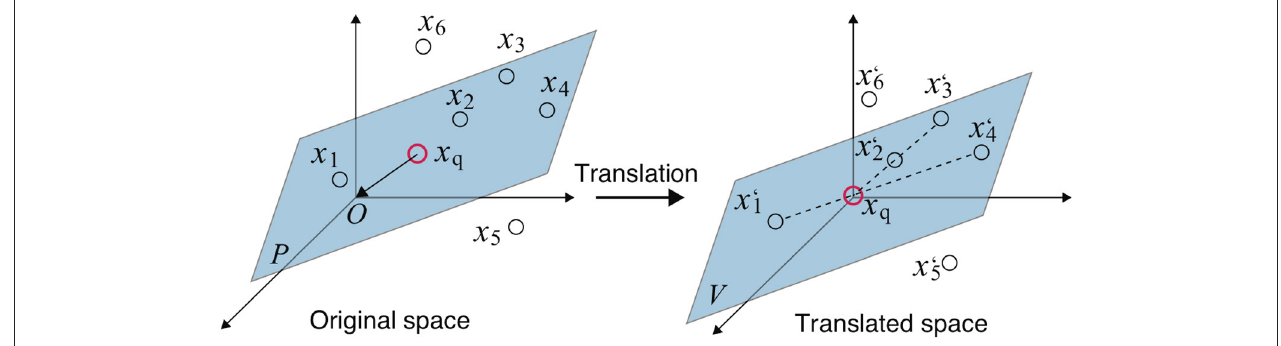
FIGURE 1 | Example of the NC method: A red circle is the query x q . Dashed lines denote pairs of samples, whose correlation is similar to x q (left) (Fujiwara et al., 2010, 2012a,b).